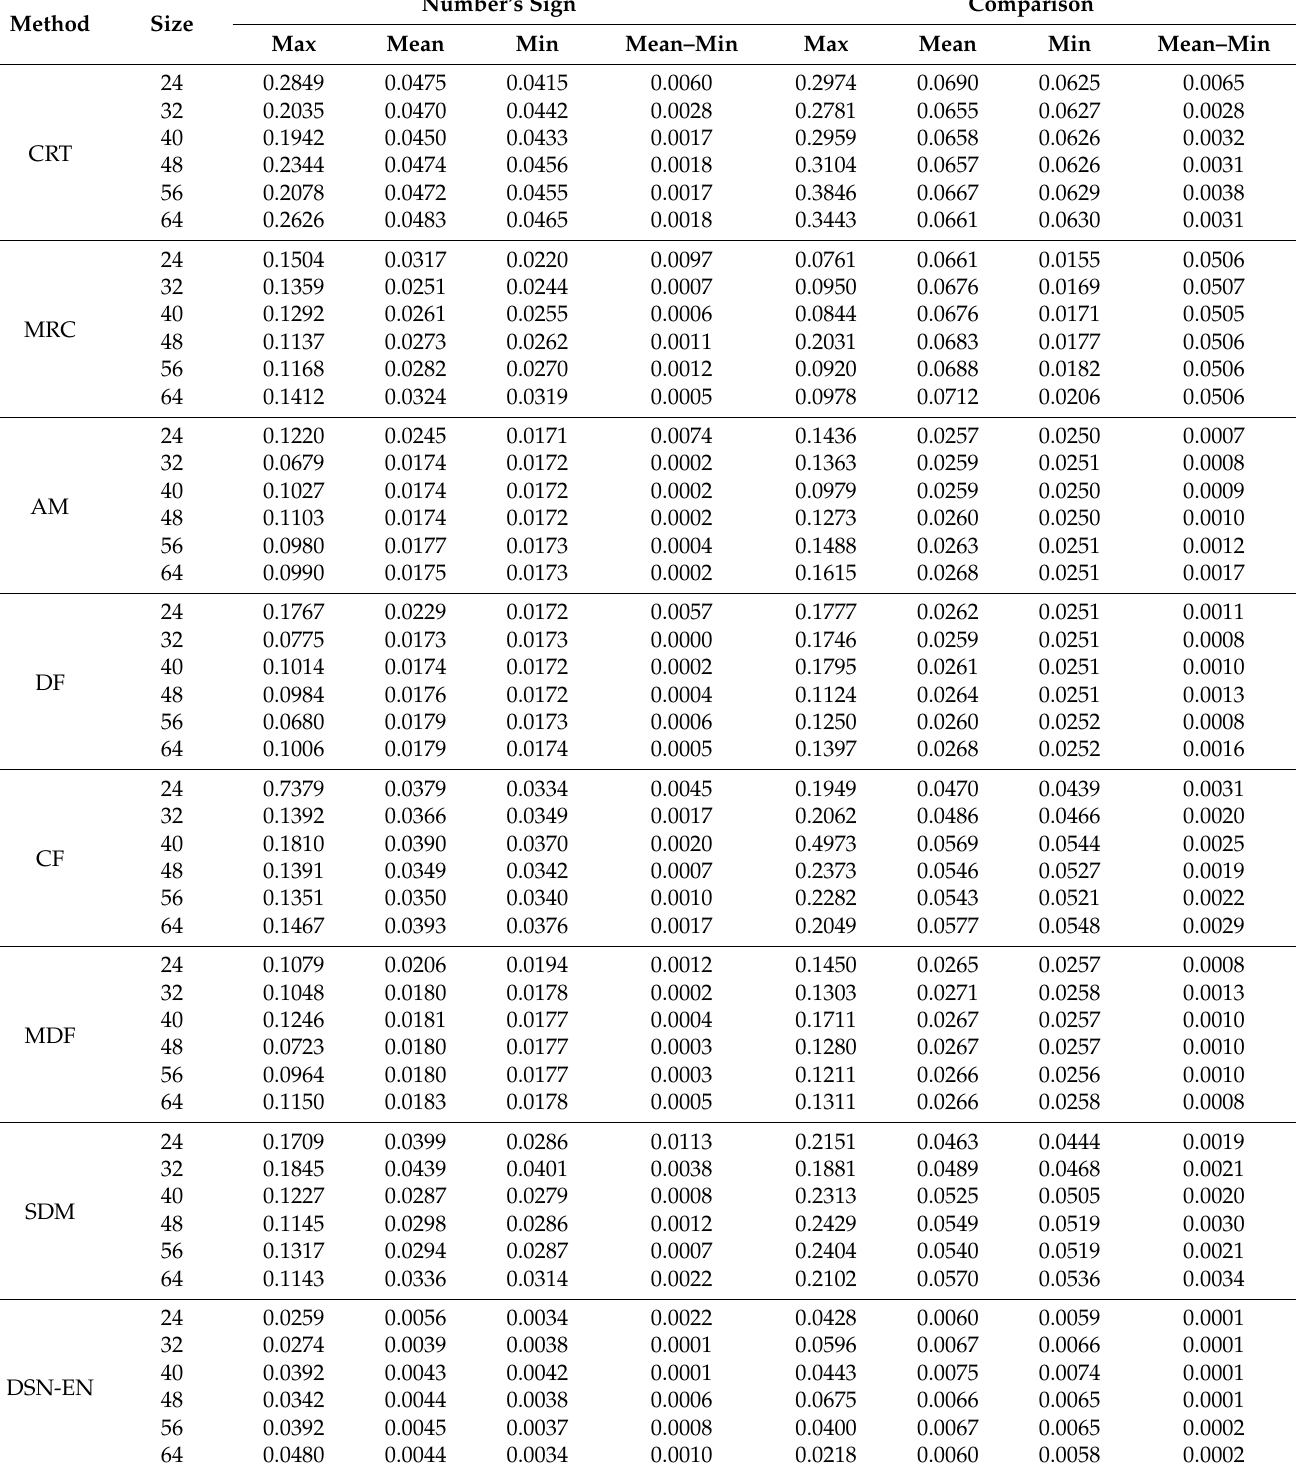
Table A2. Operation time with a dynamic bit width